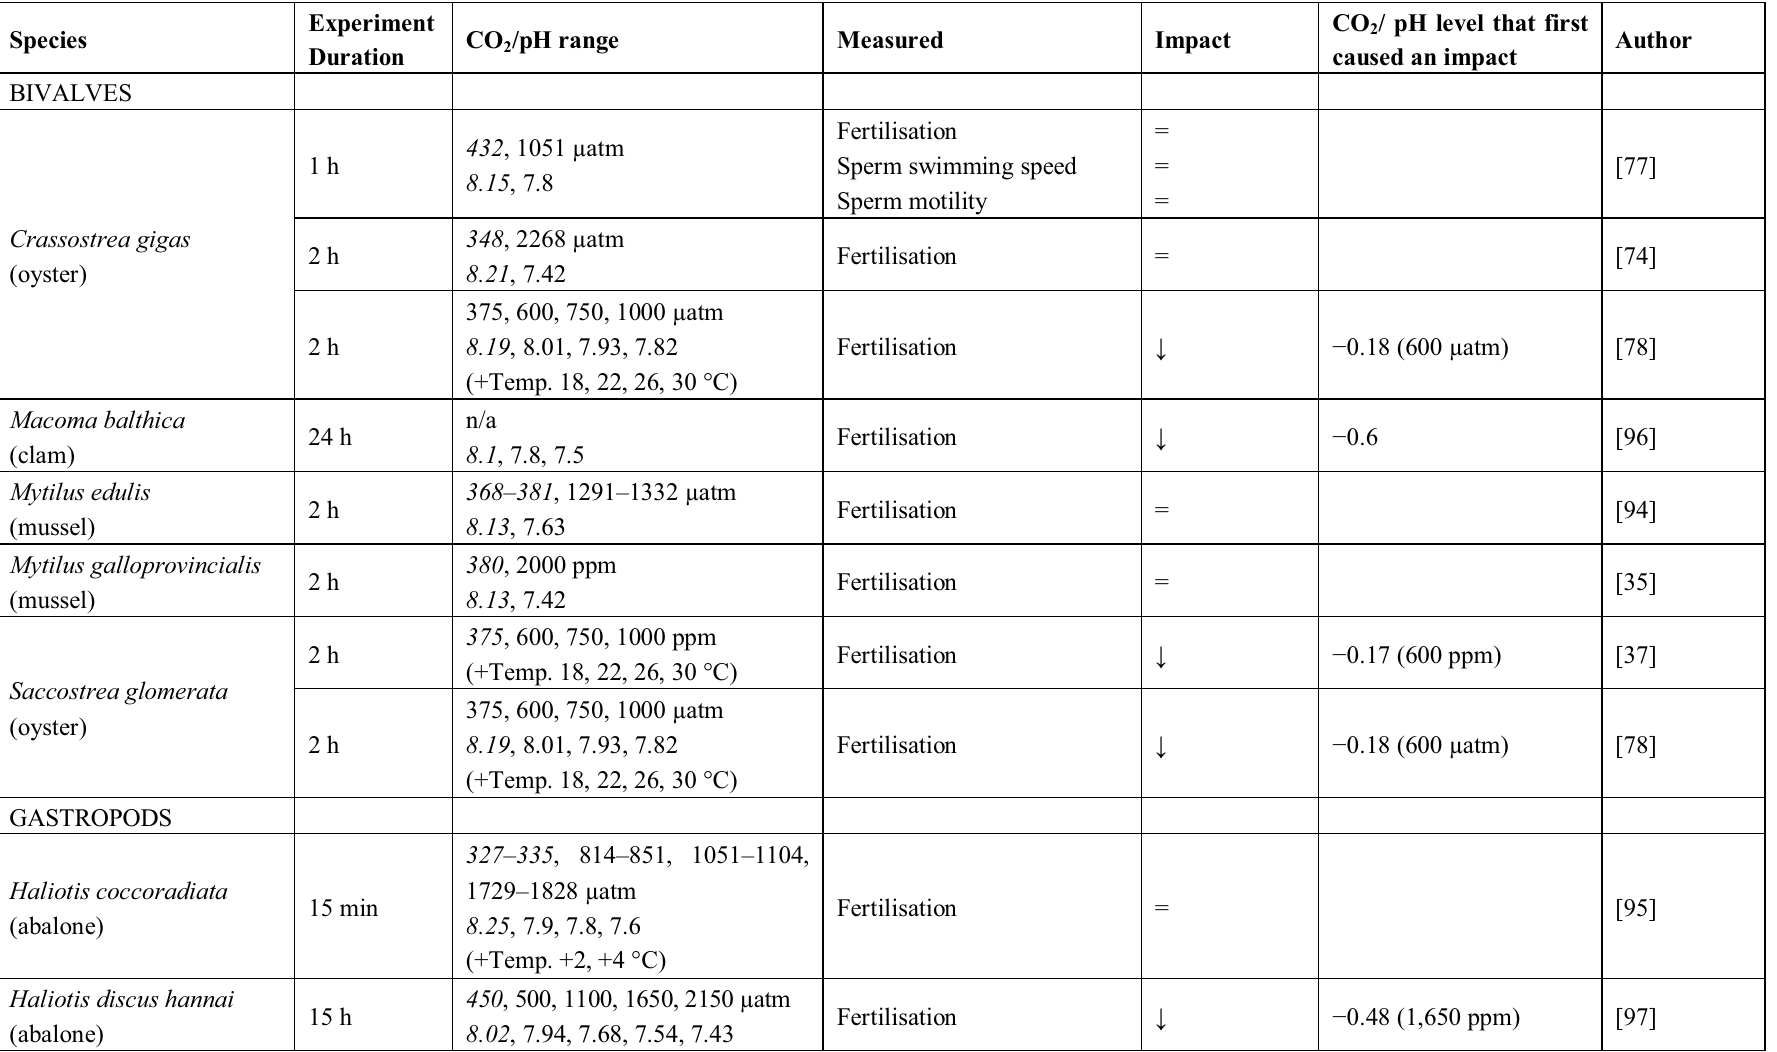
Table 2. Summary of the impacts of ocean acidification on the fertilisation of